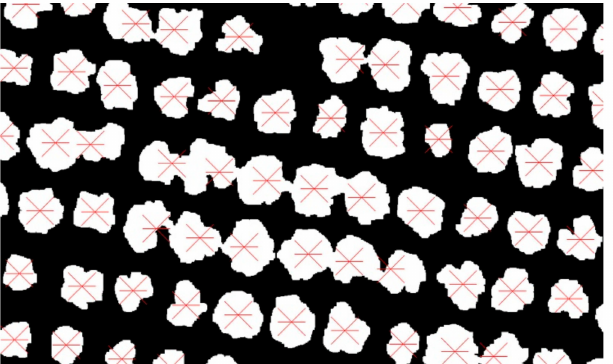
Figure 13. Result of the estimation of the individual tree location